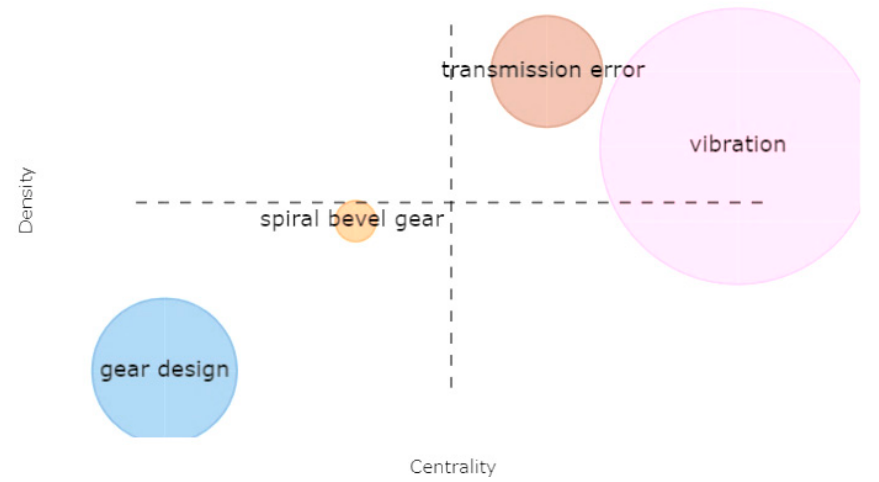
Figure 2. Thematic map, according to the papers found.